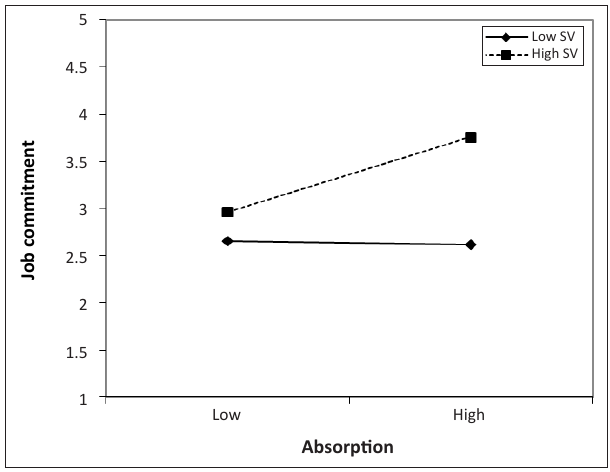
FIGURE 3: Service/dedication to a cause (SV) as a moderator of the relationship between absorption (work engagement) and job